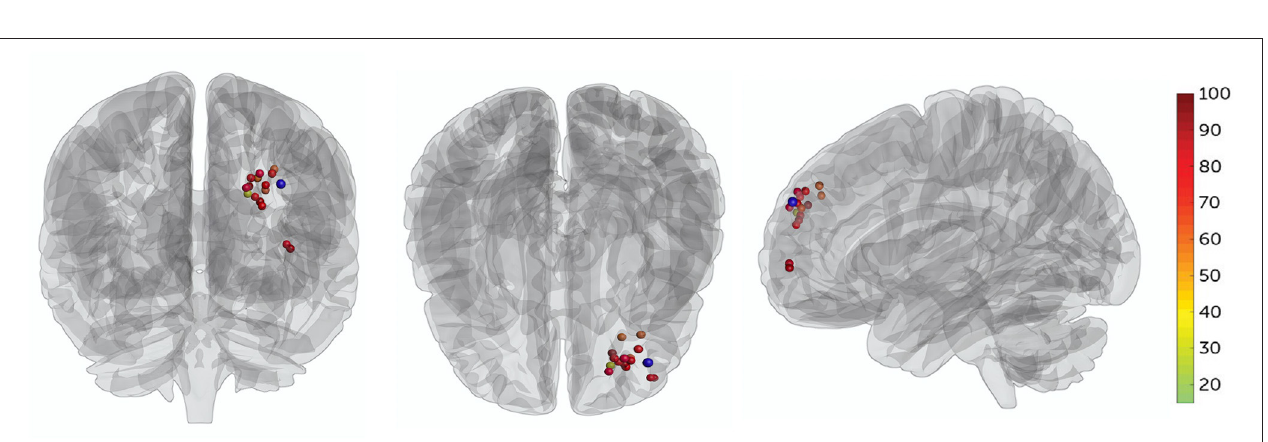
FIGURE 2 | All patients’ target locations for IT-TMS therapy. The colors of the targets represent the percentage change in BSI-CV (Beck Scale for Suicidal Ideation—Chinese Version) score after a 5-day therapy, dark red indicating great changes. The F3 location (MNI coordinates − 35.3, 49.4, 32.4) is shown in blue.